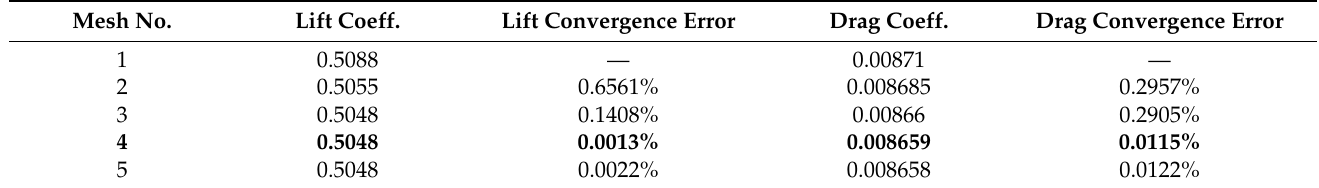
Table 5. Convergence errors for each mesh.